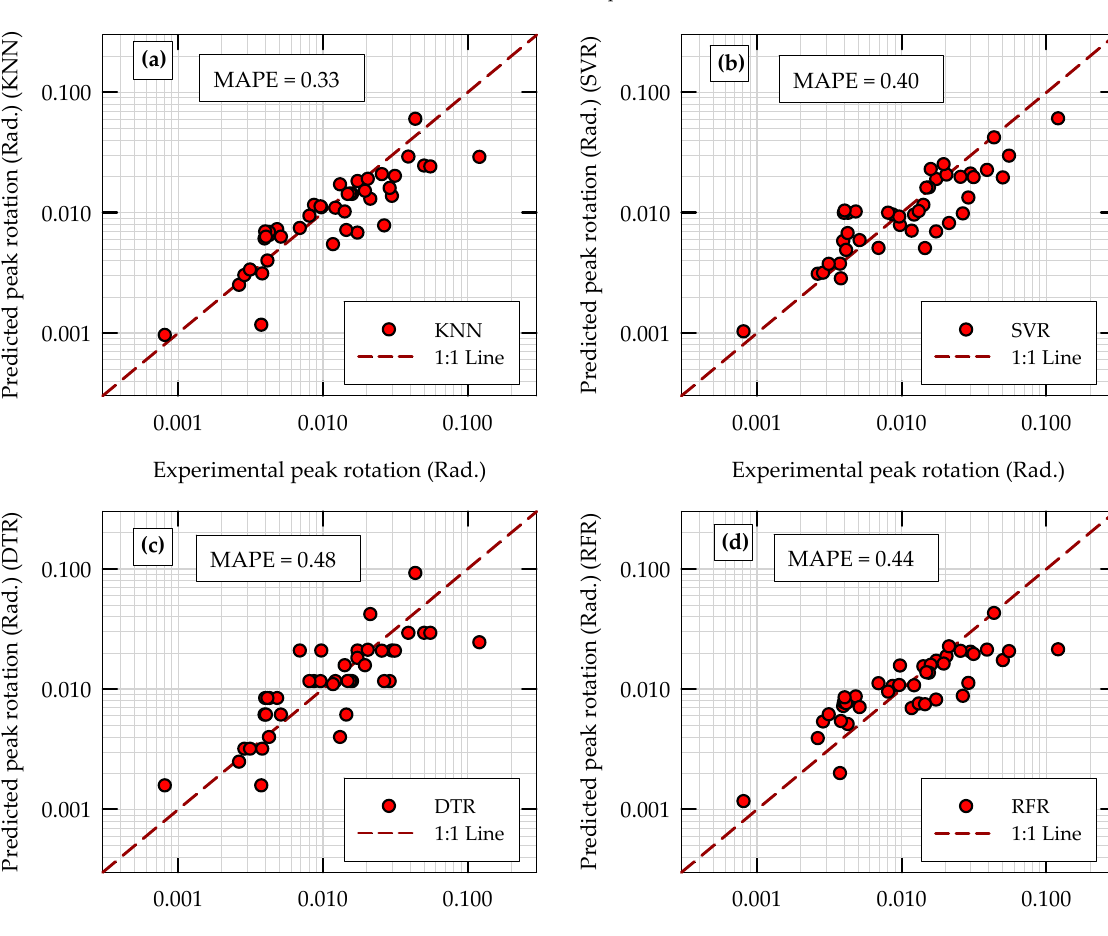
Figure 7. Comparisons of machine learning model predictions with experimental results for peak rotation of rocking foundation during initial testing phase of models: ( a ) KNN model (with k = 3), ( b ) SVR model (with C = 20 and ε = 0.1), ( c ) DTR model (with maximum depth of tree = 6), and ( d ) RFR model (with number of trees = 100).